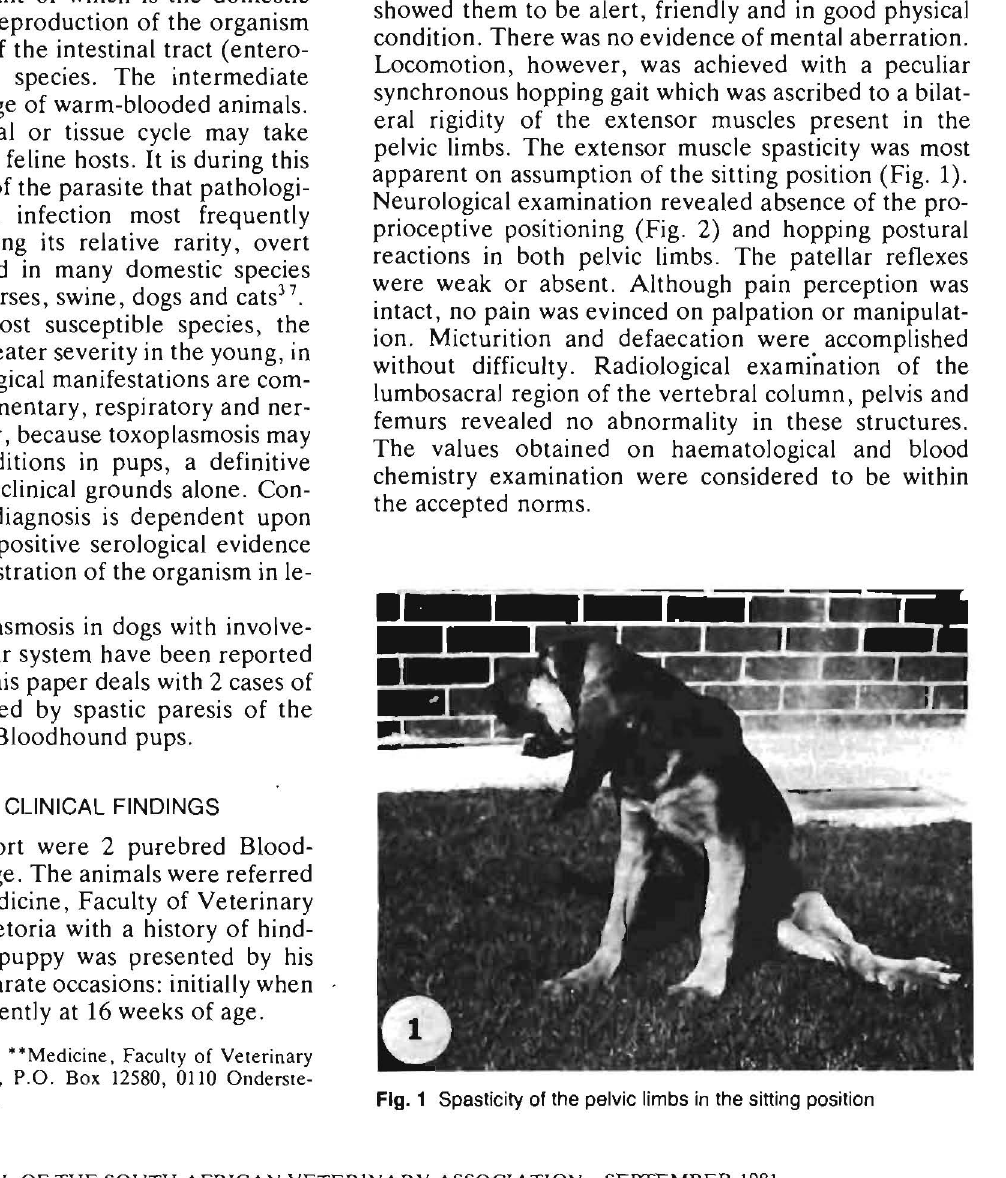
Fig. 1 Spasticity of the pelvic limbs in the sitting